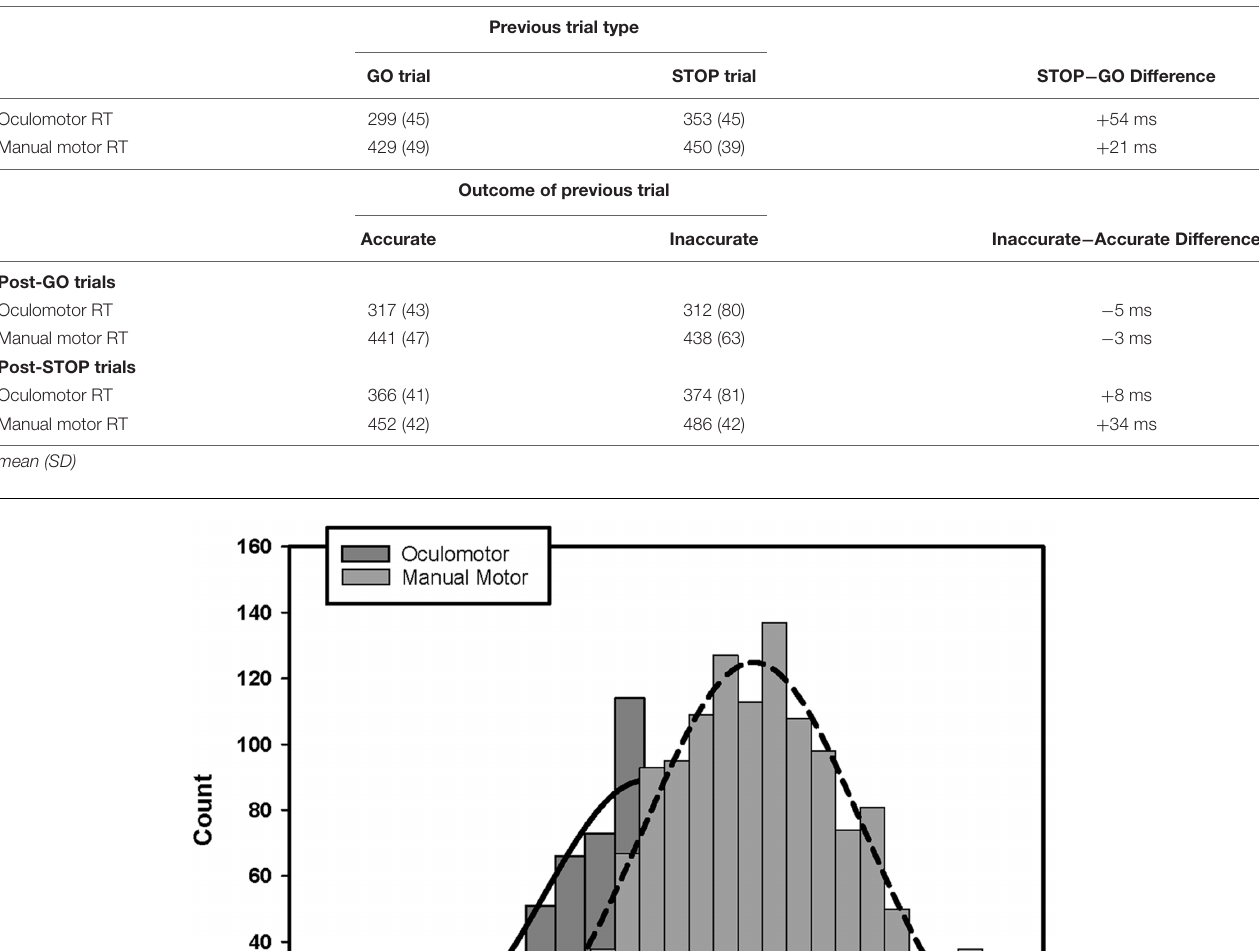
TABLE 3 | GO trial reaction times during the Stop Signal test for eye and hand movements separated by whether trials followed a GO trial or a STOP trial and by whether trials followed accurate or inaccurate trials on both GO and STOP trials.